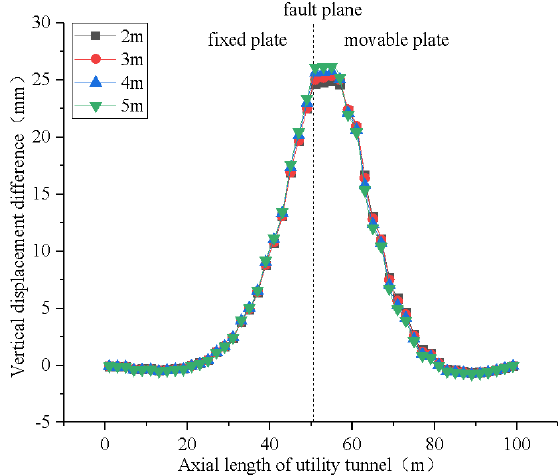
Figure 11. Vertical displacement difference distribution curve.